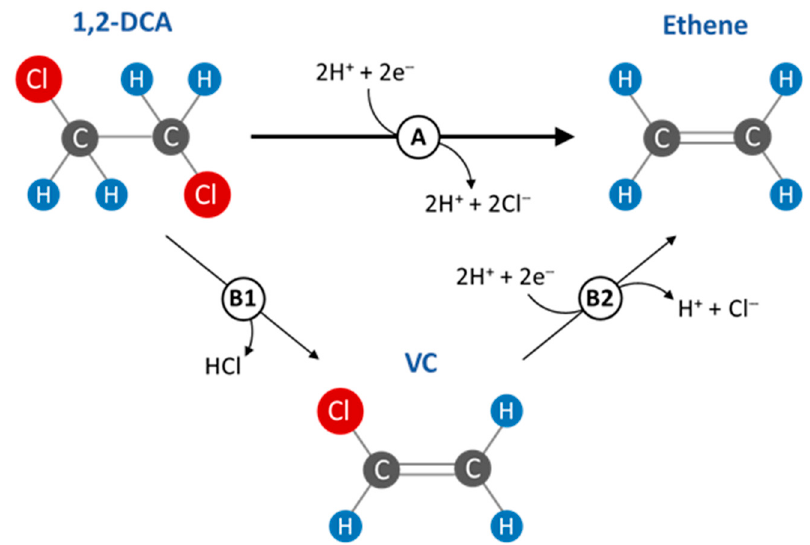
Figure 1. Different degradation pathways of 1,2-DCA: ( A ) dichloroelimination; ( B1 ) Dehydrochlorination; ( B2 ) Reductive hydrogenolysis. Steps ( A ) and ( B2 ) are driven by microorganisms, while ( B1 ) is an abiotic reaction.